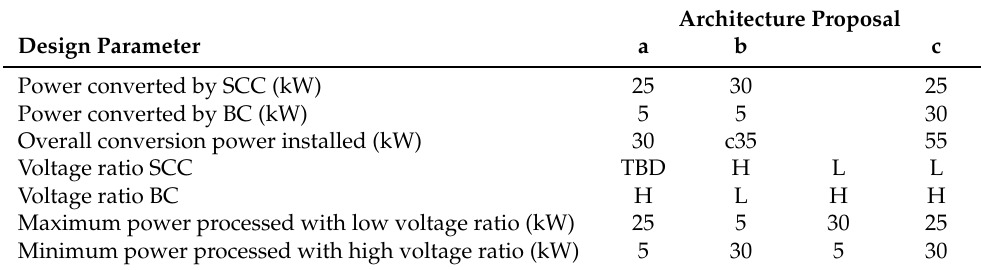
Table 3. Comparison of different system